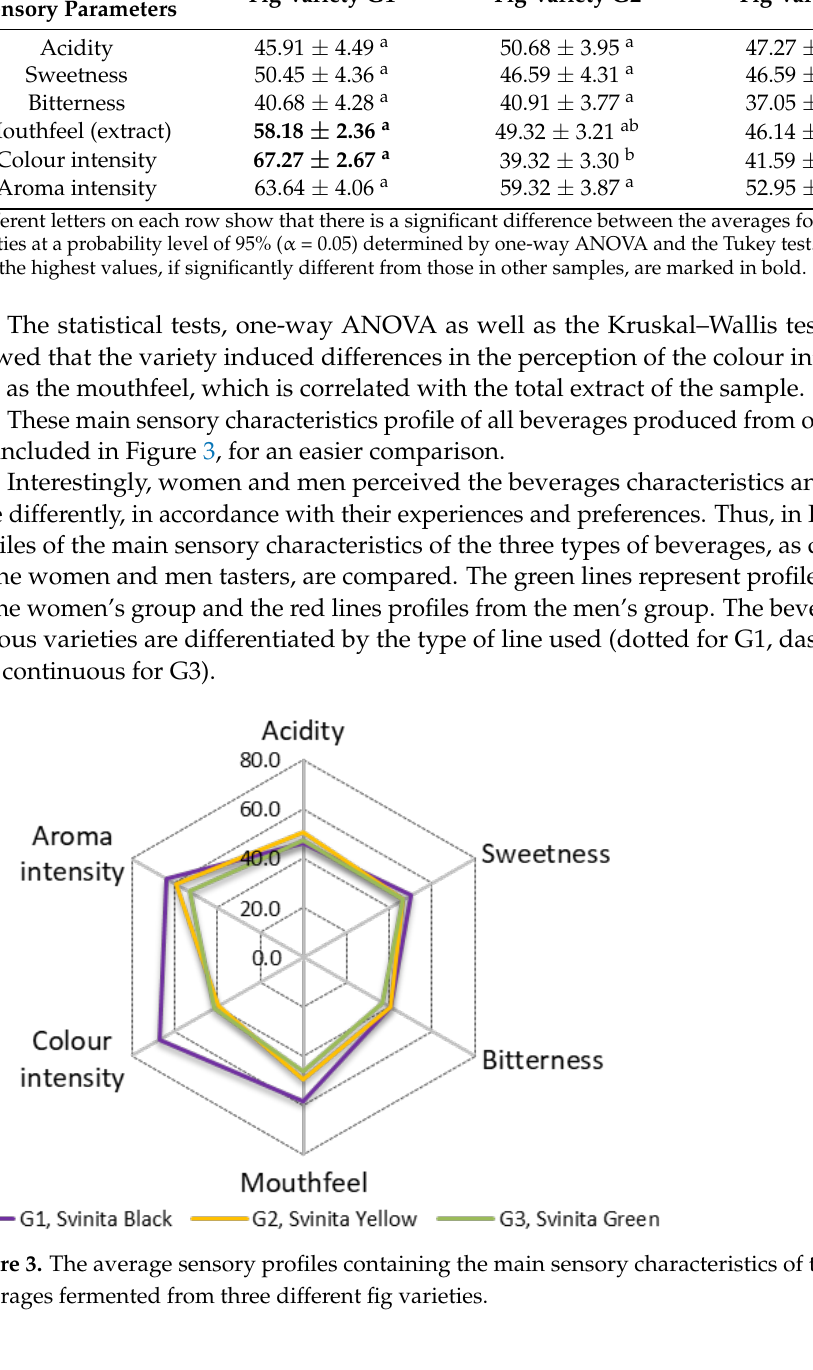
Figure 4. Gender comparisons of sensory perception of beverages from G1 (dotted lines), G2 (dashed lines) and G3 (continuous line); green lines —women’s perception (F), red lines—men’s perception (M). For each alcoholic beverage fermented from figs the tasters identified several aroma attributes for which they also provided an evaluation of the intensity of perception. Several attributes were identified by the tasters to describe the fig alcoholic bever- ages. Of the total 14 descriptors used, 8 of them (apple, grapefruit, peach, quince, raisins, pear, honey and lemon) were found in all three products. Fig and bitter almond aroma were identified in the green and yellow varieties, grass only in the green variety and strawberry and raspberry only in the black variety. Wherever possible, the aroma de- scriptors were classified either as varietal aroma or fermentation aroma (Figures 5 and